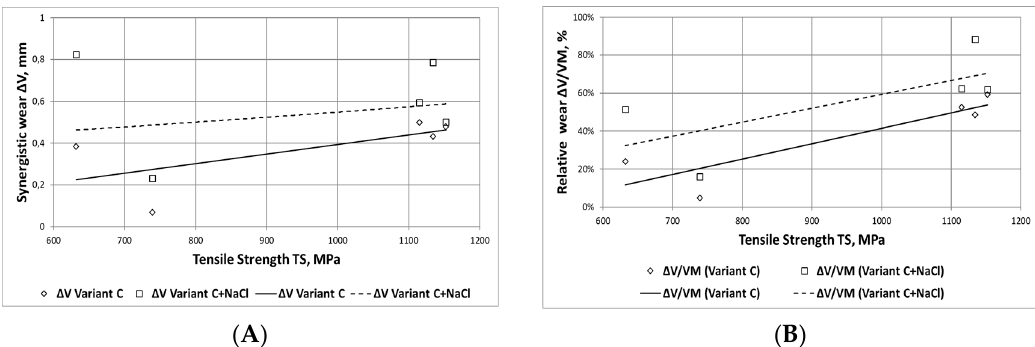
Figure 16. Synergistic components of tribocorrosion in the function of maximum strength, ( A )— Δ V component values, ( B )—relative wear increment Δ V/V M .